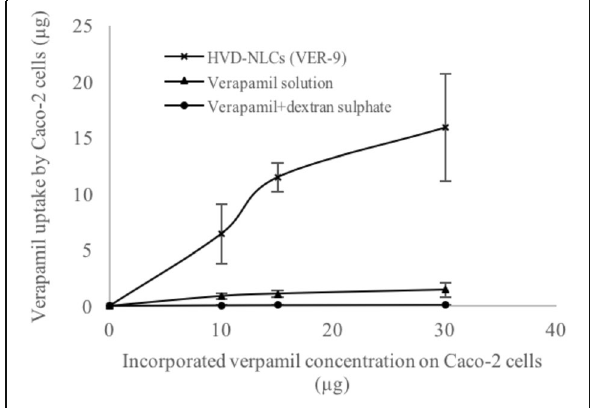
Fig. 12 In vitro model of Caco-2 cell line showing cellular uptake of HVD-NLCs (VER-9), verapamil solution, and verapamil-dextran complex (mean ± SD, n = 3)